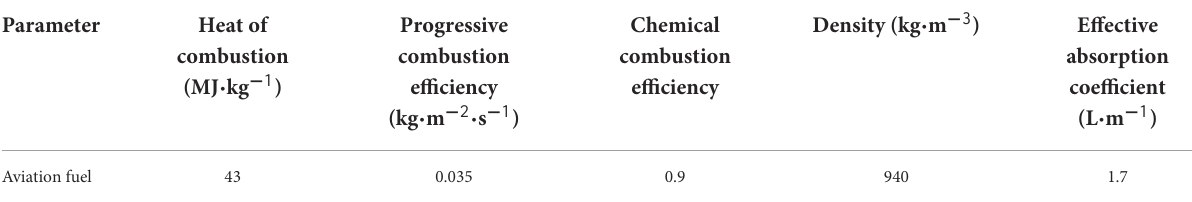
TABLE 3 Main property parameters of aviation fuel (11, 12).